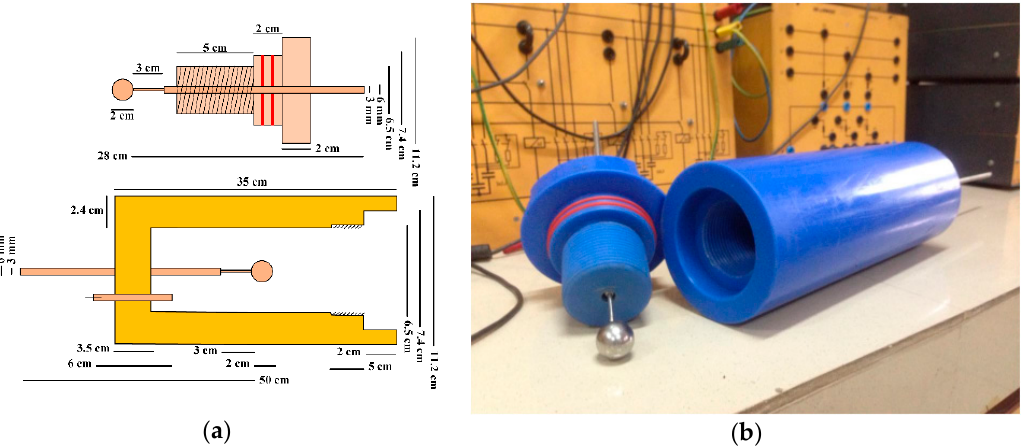
Figure 10. ( a ) Cross-sectional view and dimensional specifications of designed sphere gap discharge chamber; ( b ) Enclosed sphere gap discharge chamber fabricated as per design specifications of Figure 10a.